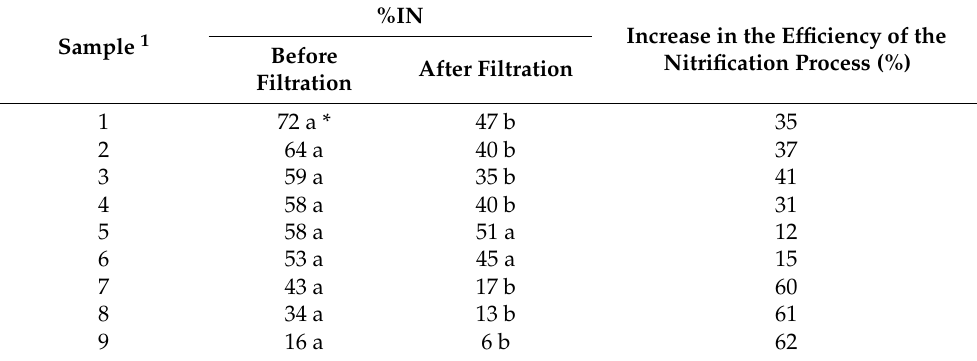
Table 5. Reduction of the effect of nitrification inhibition under the influence of sewage filtration in ash